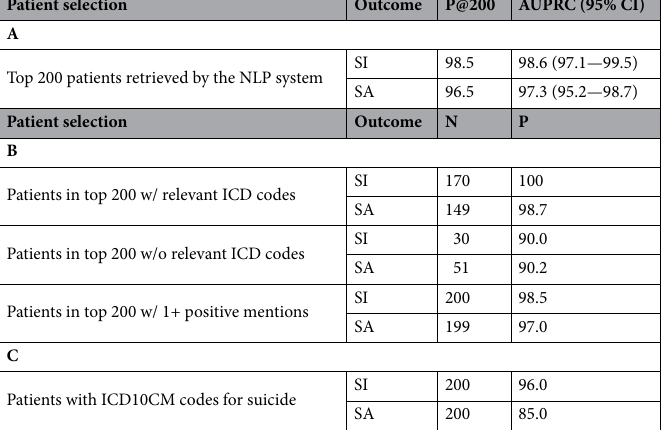
Patient selection